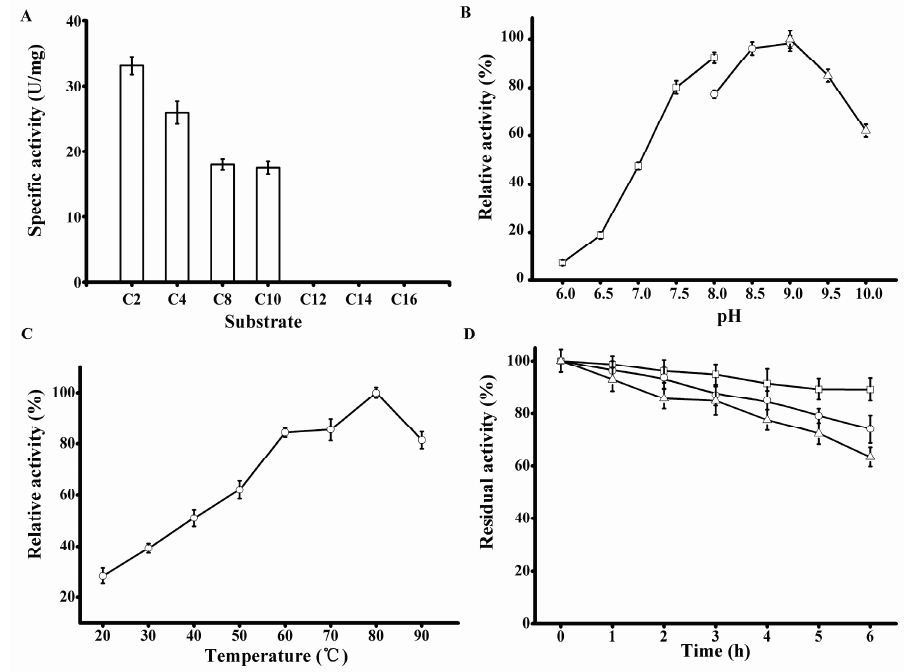
Figure 6. Biochemical characterization of the purified rP186_1588. ( A ) Activities of rP186_1588 towards p -NP esters with various chain lengths (C2, acetate; C4,